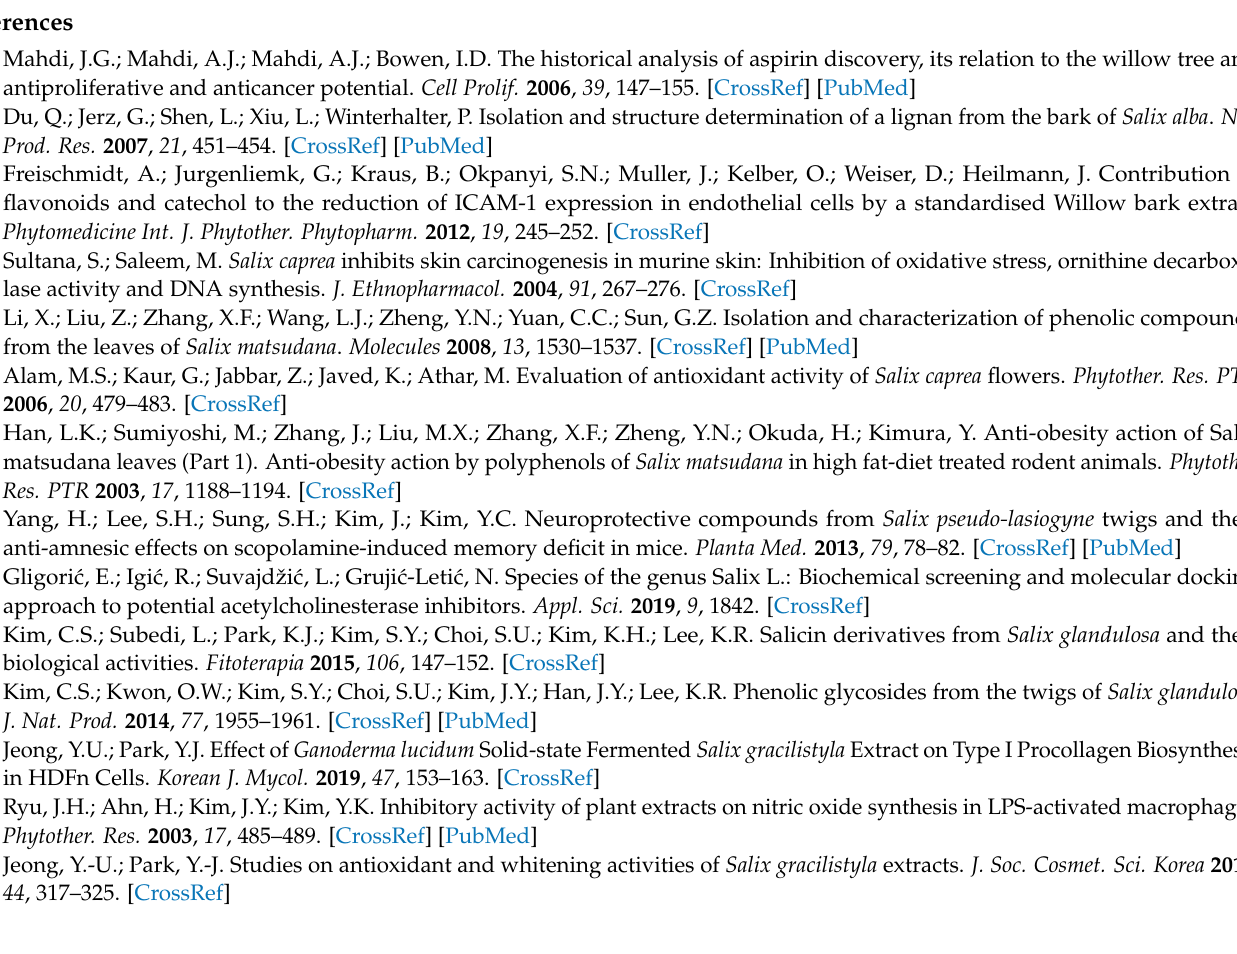
Figure S5: The 1 H NMR spectrum of Compound 3 (DMSO- d 6 , 850 MHz); Figure S6: The HR-ESIMS data for Compound 3 ; Figure S7: The 1 H NMR spectrum of Compound 4 (DMSO- d 6 , 850 MHz); Figure S8: The HR-ESIMS data for Compound 4 ; Figure S9: The 1 H NMR spectrum of Compound 5 (CD 3 OD, 850 MHz); Figure S10: The HR-ESIMS data for Compound 5 ; Figure S11: The 1 H NMR spectrum of Compound 6 (CD 3 OD, 850 MHz); Figure S12: The HR-ESIMS data for Compound 6 ; Figure S13: The 1 H NMR spectrum of Compound 7 (DMSO- d 6 , 850 MHz); Figure S14: The HR-ESIMS data for Compound 7 ; Figure S15: The 1 H NMR spectrum of Compound 8 (DMSO- d 6 , 850 MHz); Figure S16: The HR-ESIMS data for Compound 8